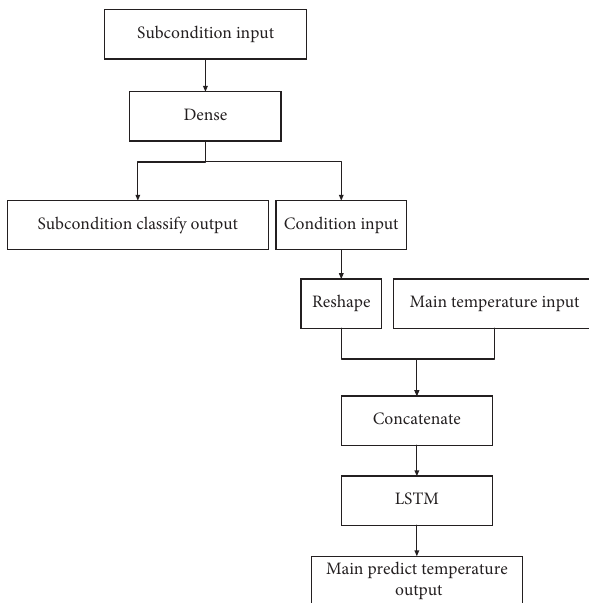
Figure 4: The bearing temperature prediction model.